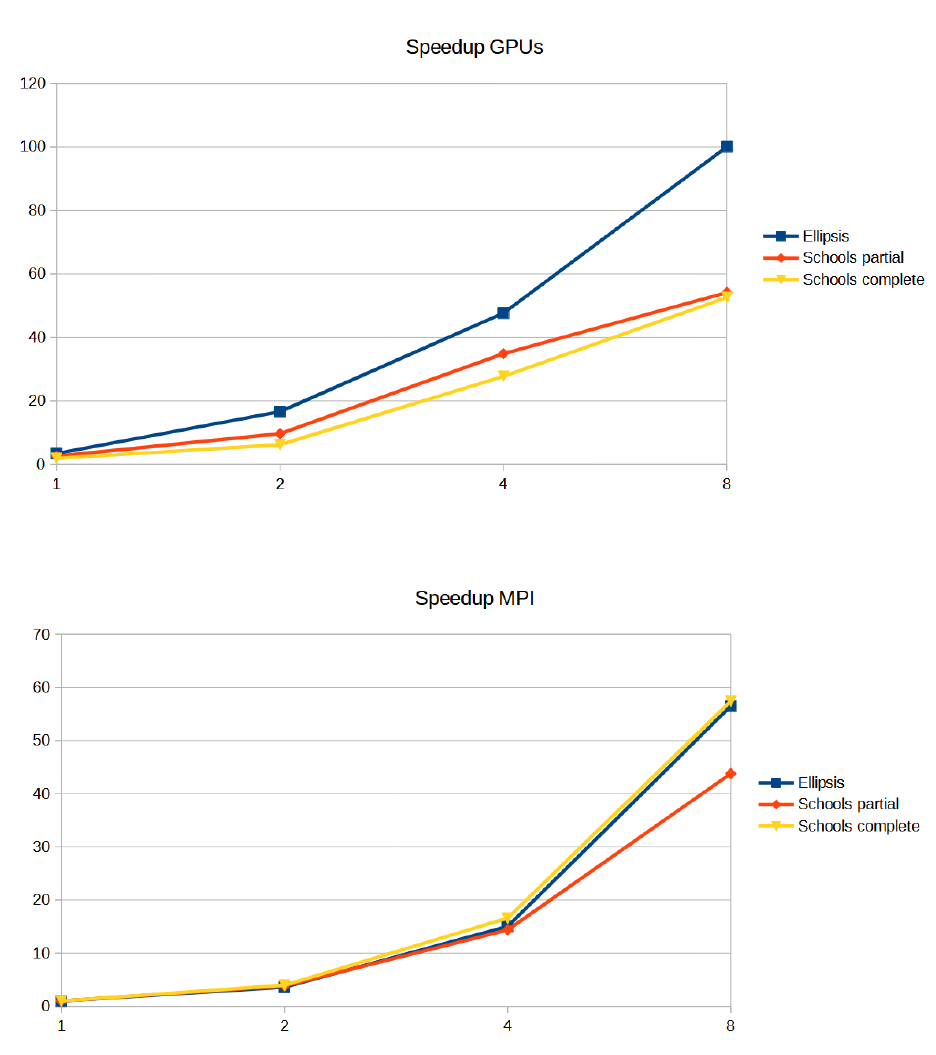
Figure 10. Achieved speedups with PFMGPU [a] and PFMMPI [b]. Figure 10. Speedups for PFMGPU ( top ) and PFMMPI ( bottom